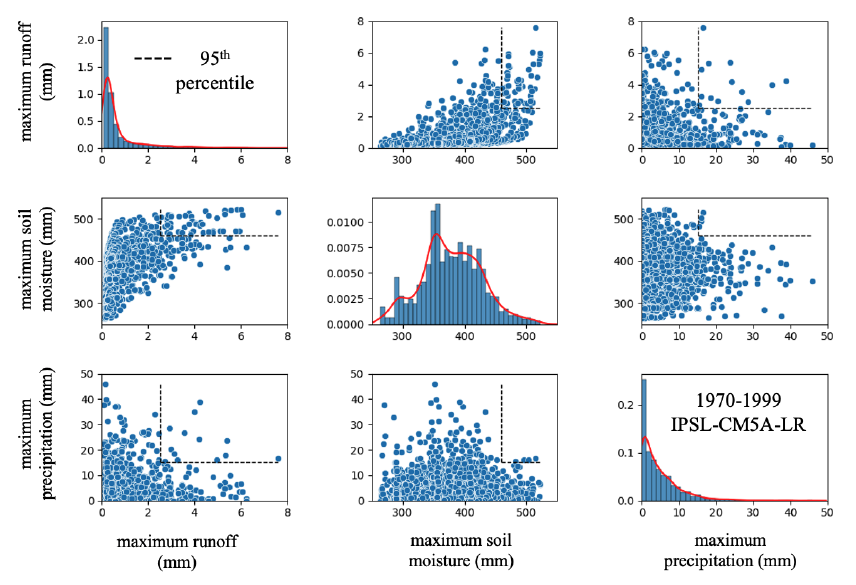
Figure 4. Input values to the copulas for the historical synoptic time series of maximum precipitation (precx, mm), maximum soil moisture (soilmx, mm), and maximum streamflow (qx, mm) for IPSL- CM5A-LR ESM for the Uncompahgre River basin in the Upper Colorado. The 95th percentile of the values is illustrated with dashed lines. Histograms show the distribution of the raw data values with lines for marginal